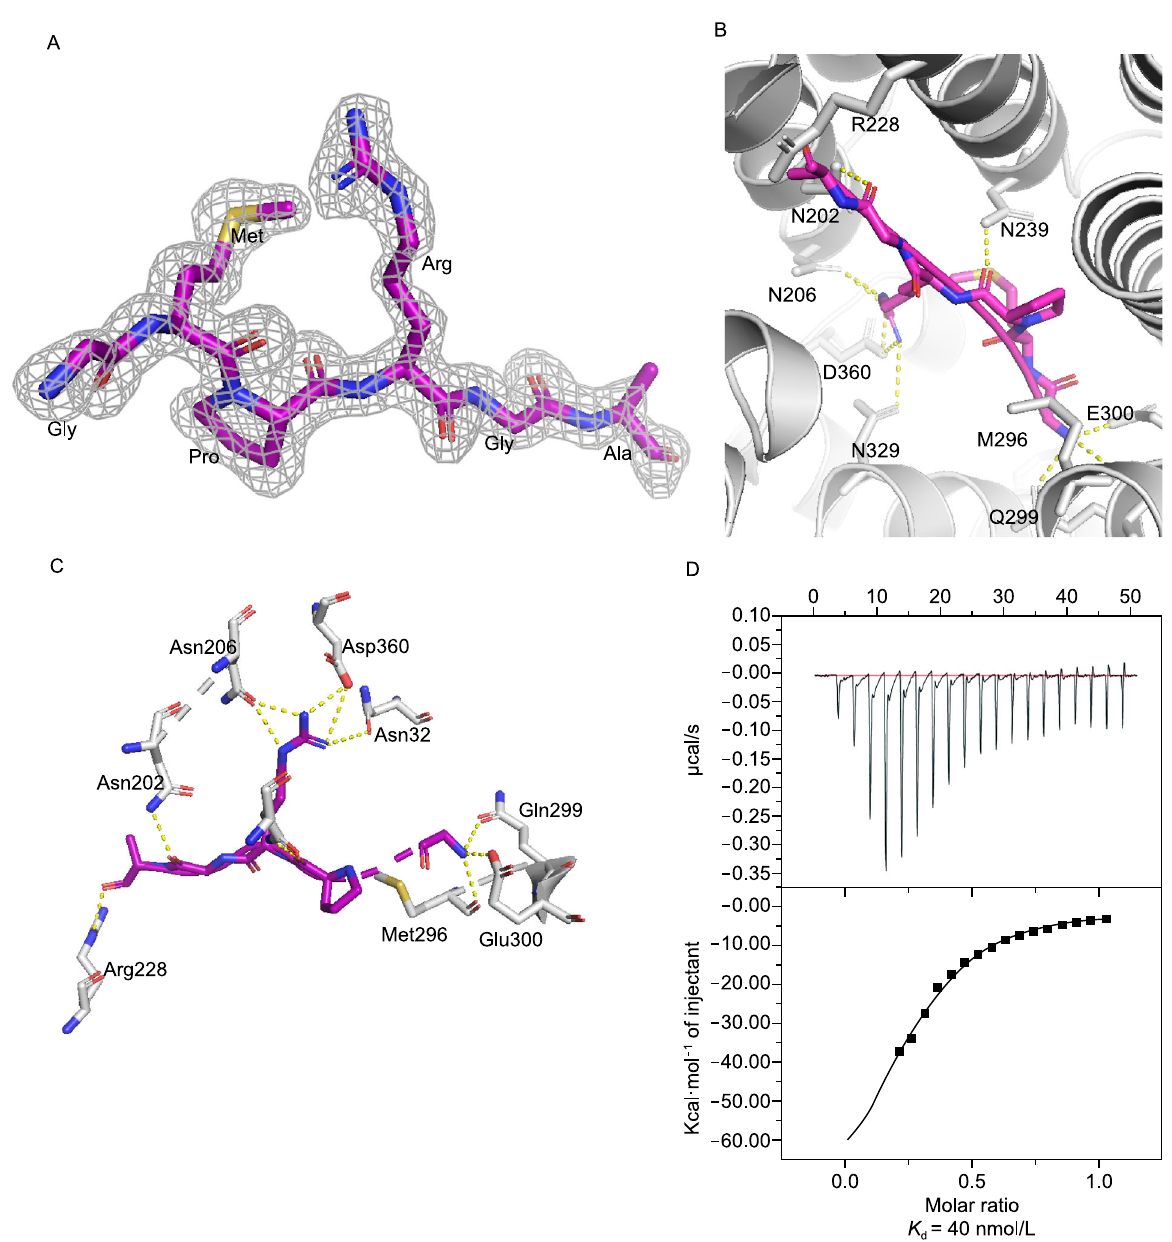
Figure 2. Recognition of AimP hexapeptide (GMPRGA) by AimR from SPbeta phage . (A) Electron density map of the AimP bound to AimR. The 2 F o- F c map, calculated by simulated annealing without peptide in the structure, is shown contoured at 1.5 σ as a gray grid with the peptide in sticks colored by atom type. (B) The binding mode between AimR and AimP. AimR is shown as cartoon colored in white, whereas the residues that interact with AimP (N202, N206, N239, Q299, E300, N329 and D360) are shown as sticks colored by atom type. AimP is shown in stick representation with purple carbons. Hydrogen bonds are depicted as dotted yellow lines. (C) Similar to (B), but showing only interacting residues from another angle of view. (D) Binding af fi nity of wild-type AimR for AimP measured by ITC. The concentration of AimP used in assay was 200 – 500 μ mol/L, and the concentration of AimR was 10 – 20 μ